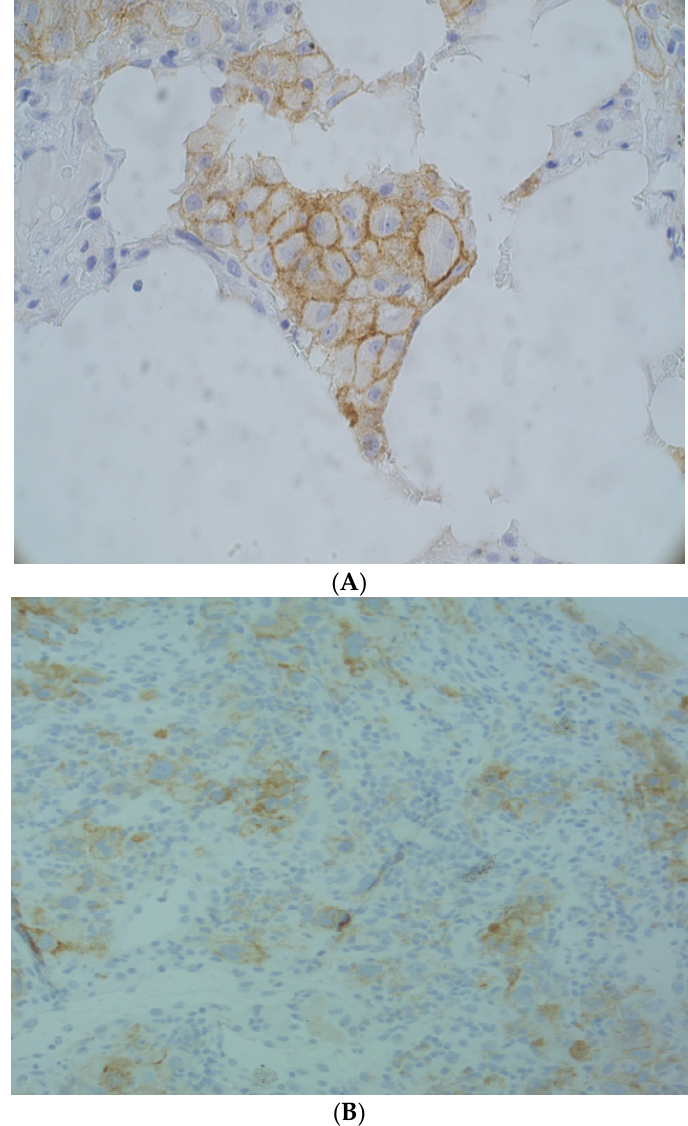
Figure 1. Non-small-cell lung cancer stained by immunohistochemistry with SP263 Antibody: ( A ) PD-L1-positive tumor cells (40× magnification); ( B ) PD-L1-positive tumor cells and immune cells (20× magnification).